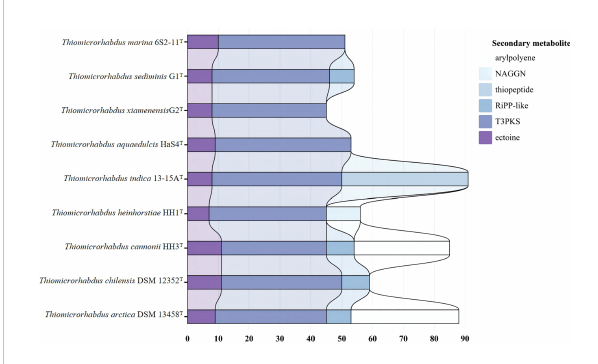
FIGURE 5 Predicted secondary metabolite results for nine strains annotated by antismash